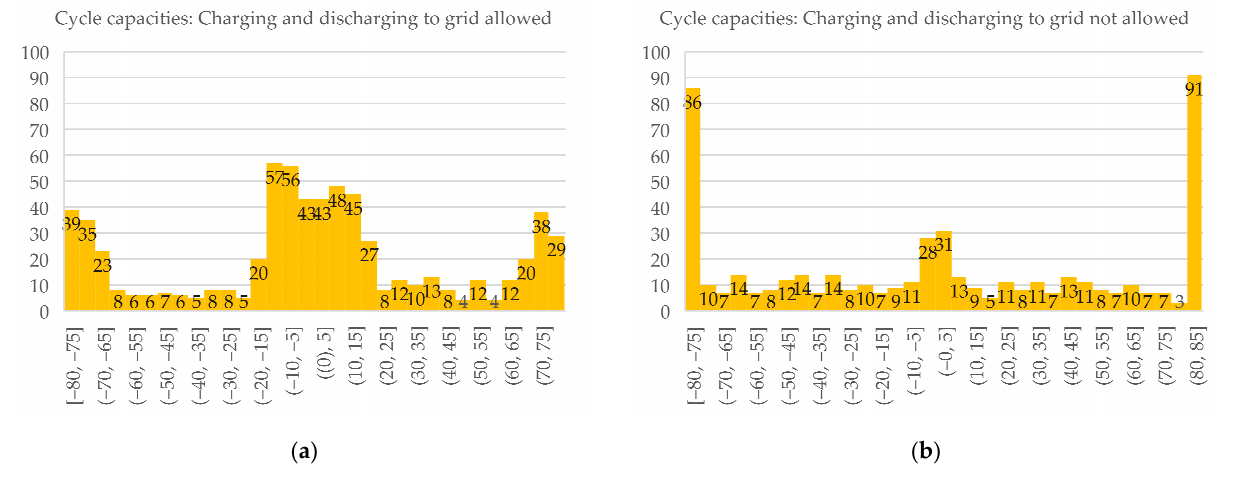
Figure A1. Comparison of BESS’s capacity for each charging and discharging operation: ( a ) Charging and discharging to grid allowed; ( b ) Charging and discharging to grid not allowed.